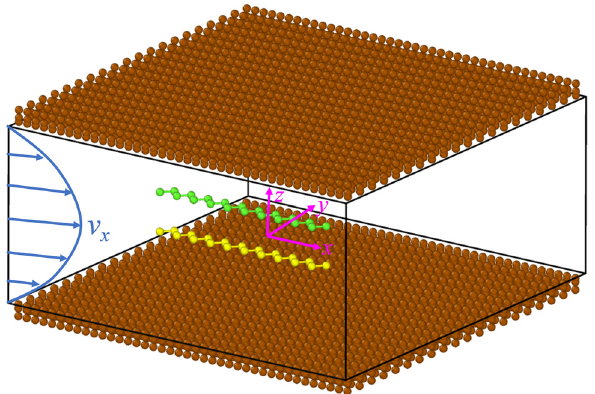
Figure 1: Schematic of the simulation system for the pressure - driven fl ow in a slit, only two wormlike chains and none of the solvent particles are shown for